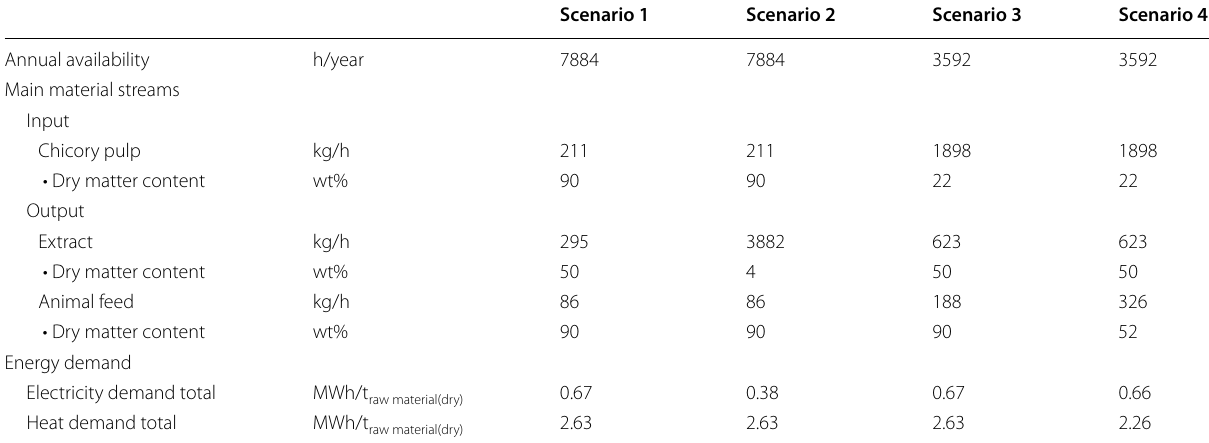
Table 3 Comparison of four techno‑economic scenarios, all assuming the same input of raw material dry matter (1500 ton/year) and the same annual production rate of extract dry matter (1163 ton/year) and animal feed dry matter (607